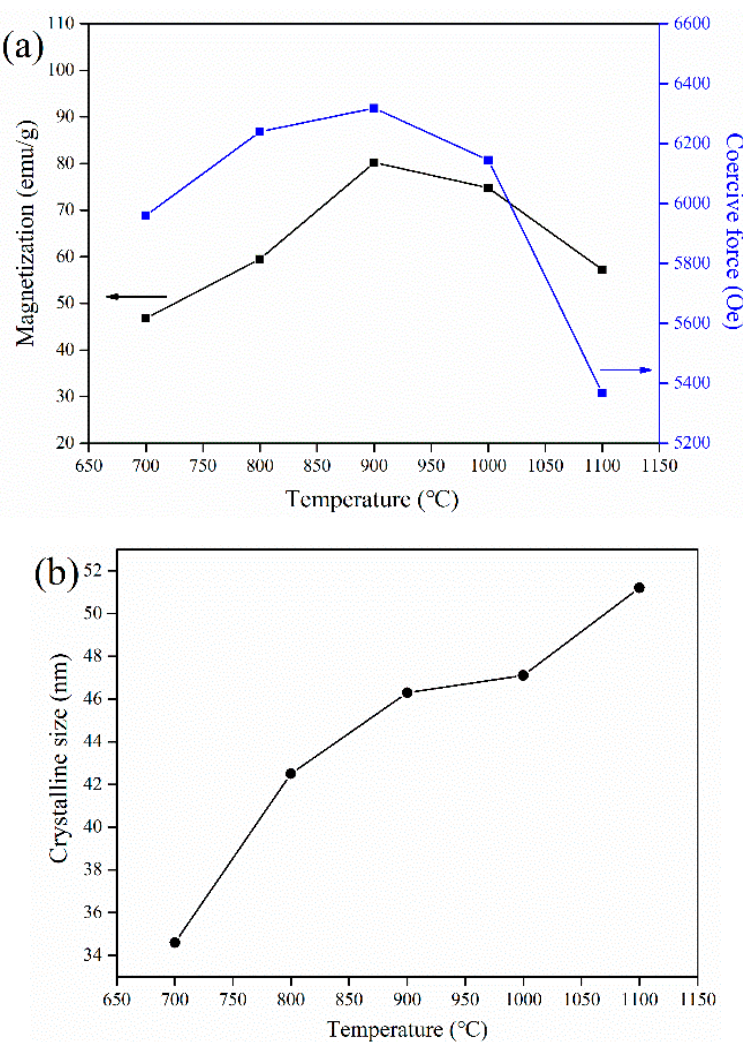
Figure 5. Effect of annealing temperature on the ( a ) magnetic properties and ( b ) crystalline size of the obtained SrFe 12 O 19 powder.